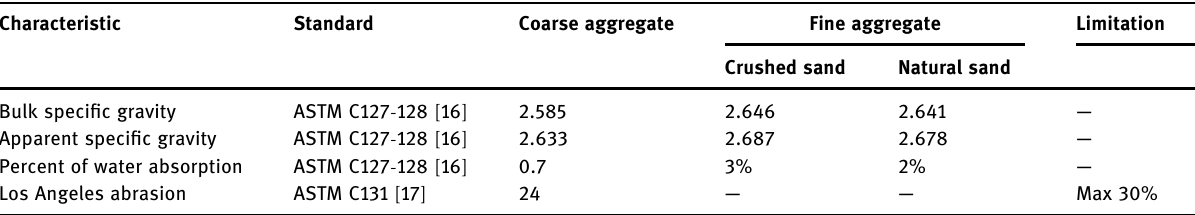
Table 2: The aggregates ’ Physical characteristics Characteristic